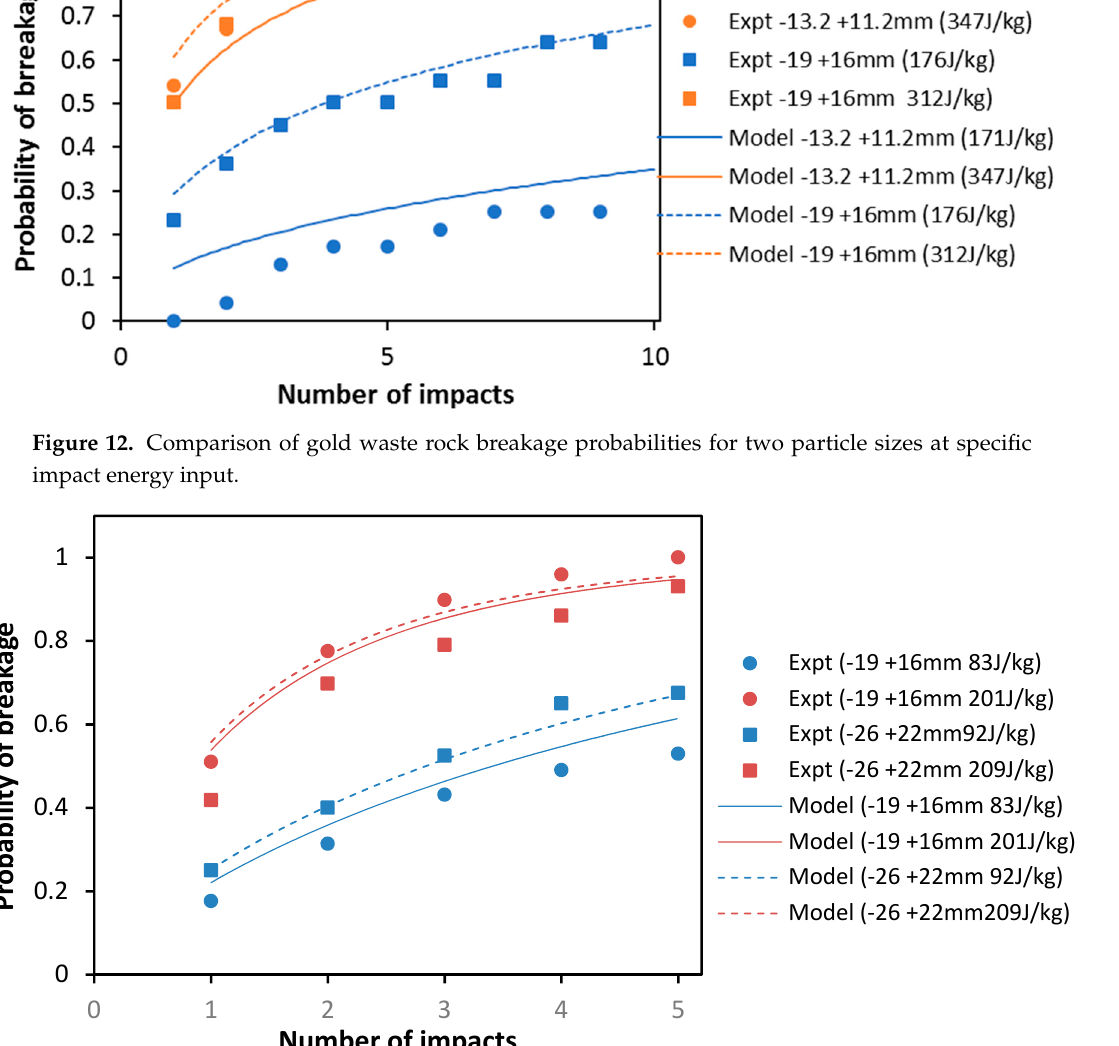
Figure 13. Comparison of silica breakage probabilities at similar specific impact energy input.